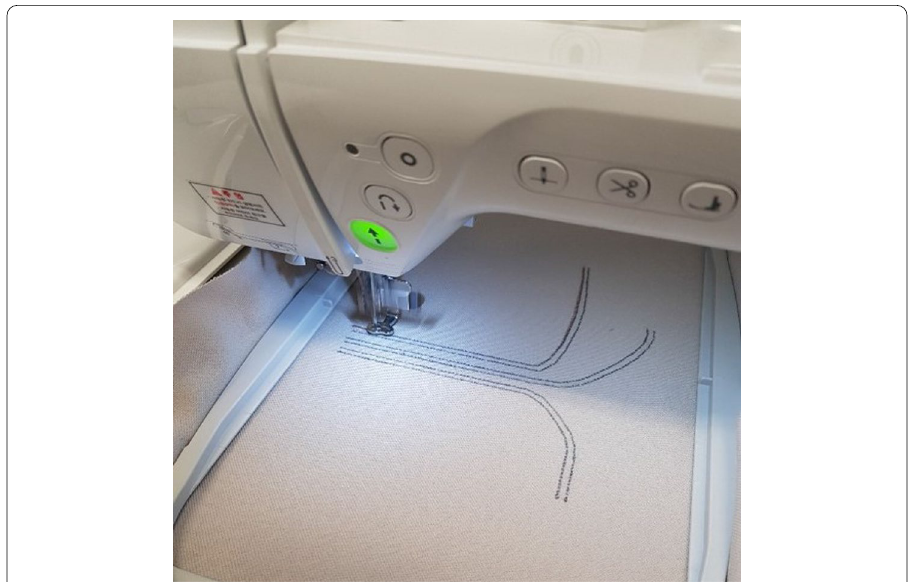
Fig. 5 Circuit design using embroidery CAD